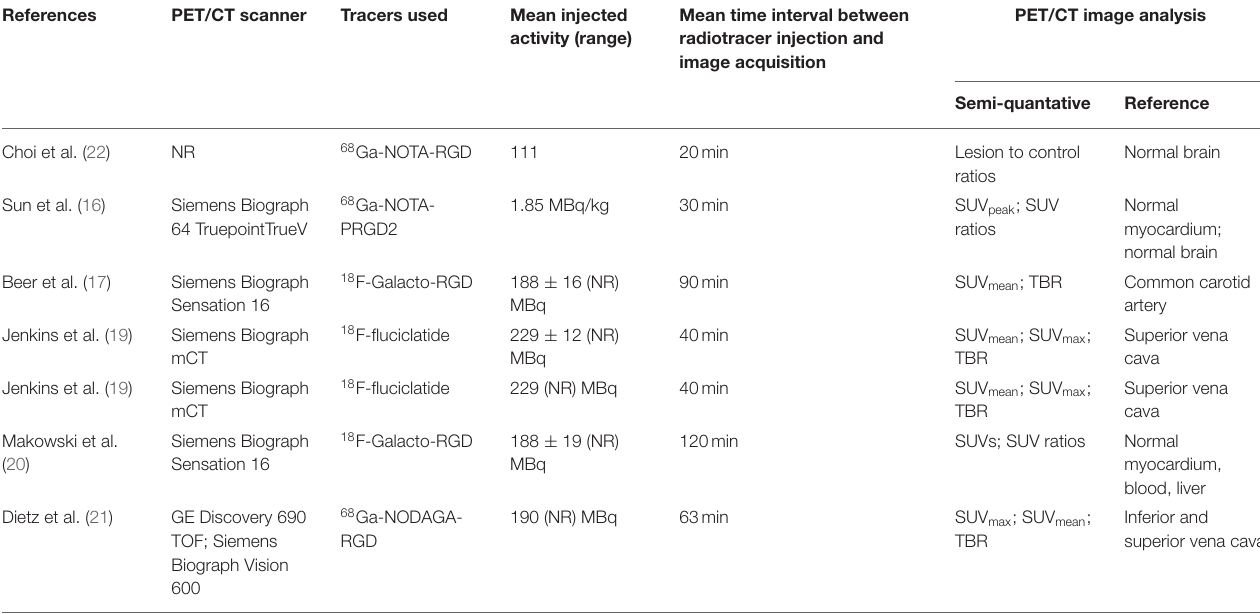
TABLE 2 | Technical aspects of RGD-based PET/CT in the included